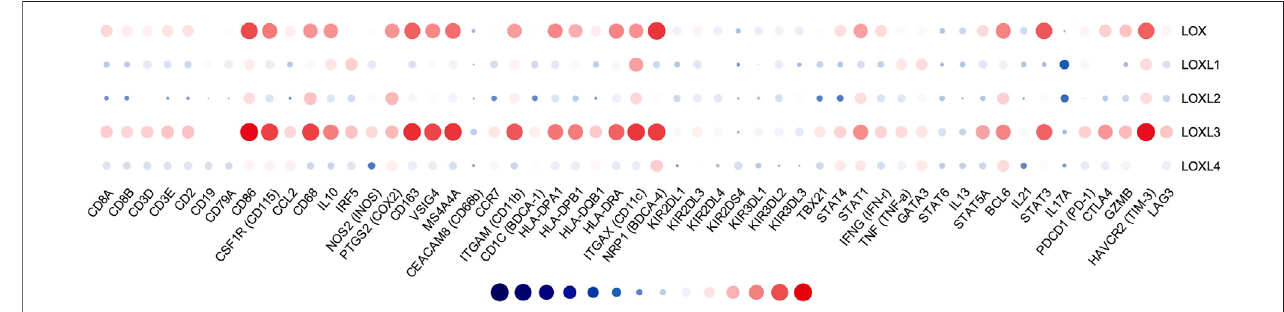
FIGURE 11 | Correlation analysis of LOXs and immune signatures in PDAC (TIMER). The correlation was adjusted by